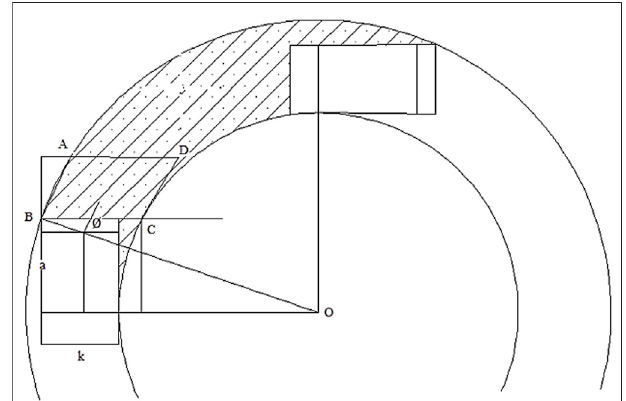
FIGURE 6 | Smart car right turn schematic.